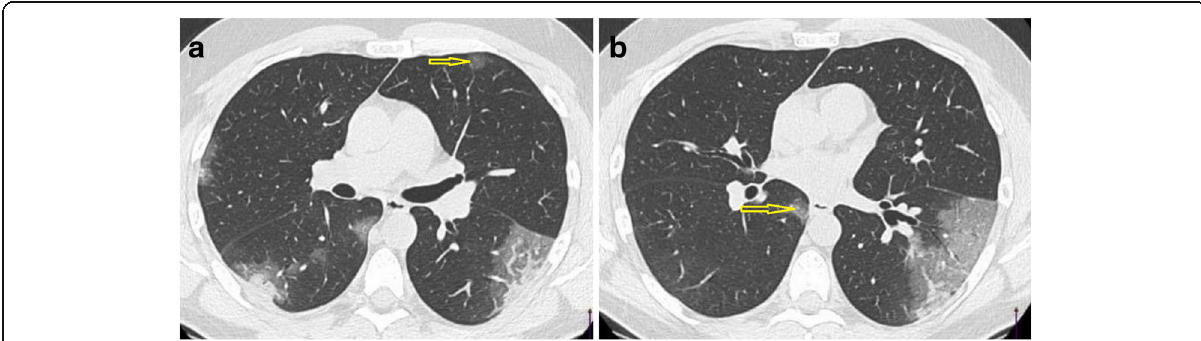
Fig. 1 CT chest axial cuts of COVID-19 patient. A: ground glass opacity (anterior segment of left upper lobe, yellow arrow) and combination of GGO and consolidation in both lower lobe (peripheral, subpleural). B: ground glass opacity (medial segment of right lower lobe, yellow arrow) as well as GGO and consolidation of left lower lobe (peripheral,